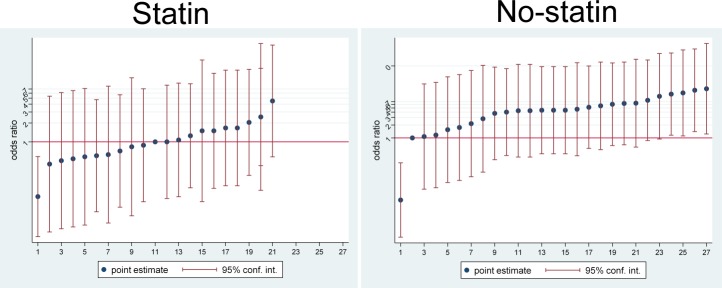
CRP level and delirium according to statin usage in the propensity matched data.The odds for delirium that was associated with preoperative statin usage is indicated by the blue circles (with corresponding 95% Cis indicated by vertical line). Result are shown according to the CRP level (x-axis).